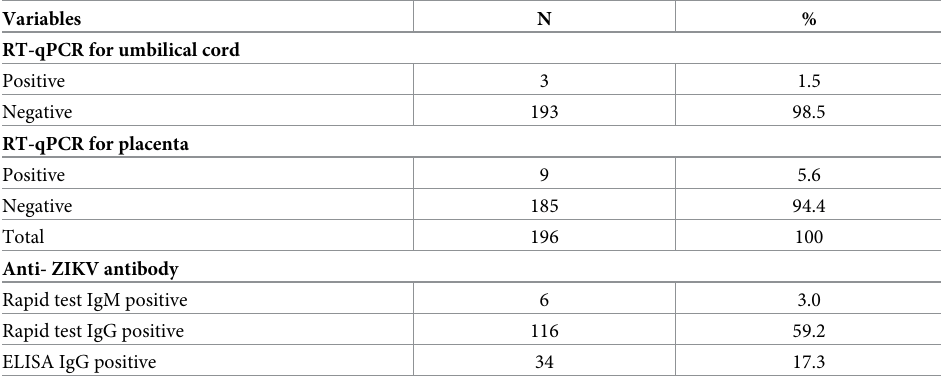
Table 1. Results of molecular tests performed on samples from pregnant women exposed to Zika virus between April 2017 and June 2018, S ã o Luı ´ s-Maranh ã